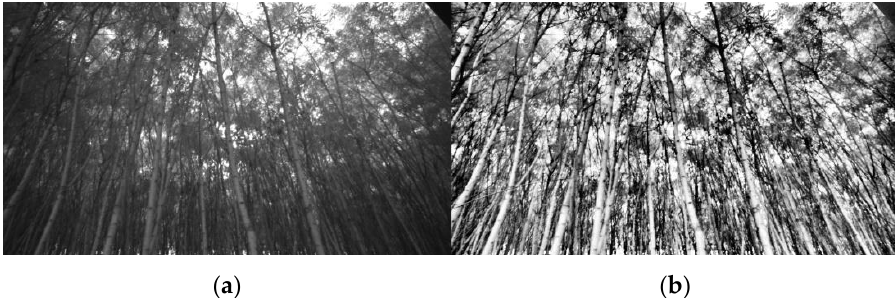
Figure 3. ( a ) Original grayscale image from the infrared imager; ( b ) grayscale image after applying the contrast-limited adaptive histogram equalization (CLAHE) algorithm.